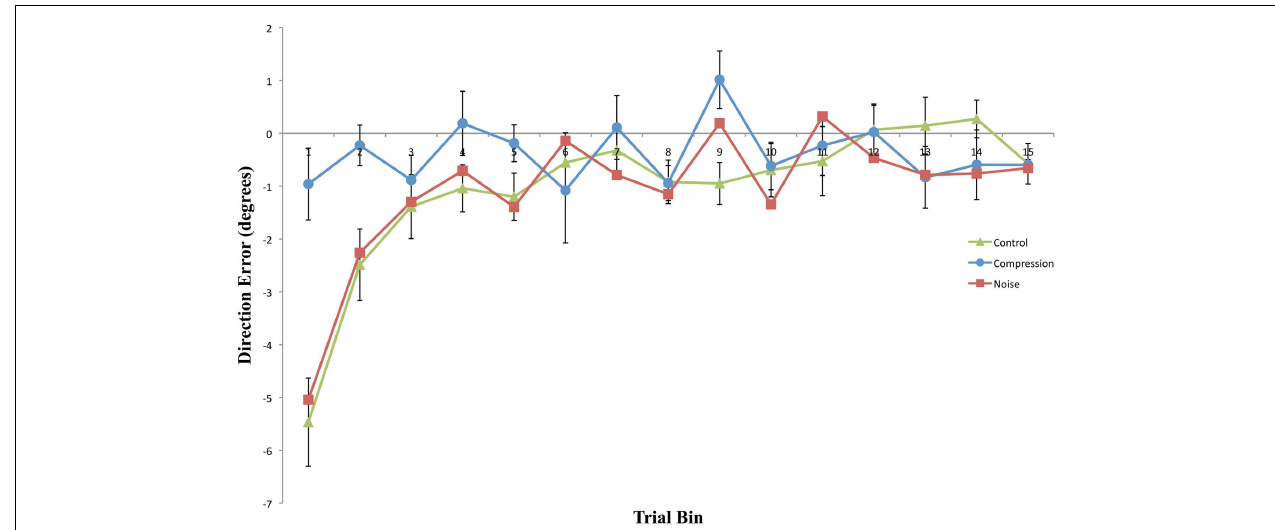
FIGURE 3 | Mean directional pointing error (with SE bars) for each two-trial bin in the Post-Adaptation phase for all three conditions . Negative values indicate a leftward error in the direction opposite to the prism displacement.